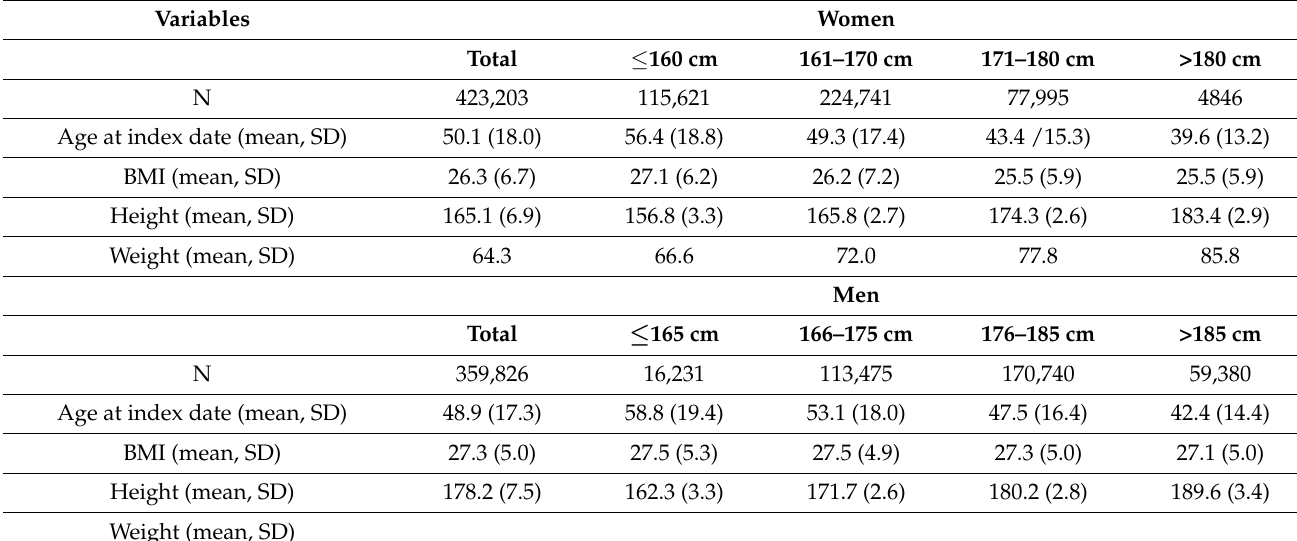
Table 1. Mean age, BMI, and body height at index